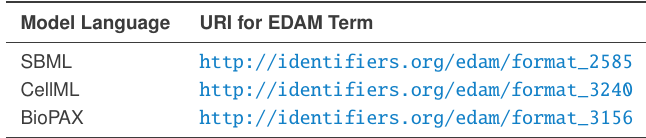
Table 10: Terms from the EDAM ontology to specify the language property of a Model .